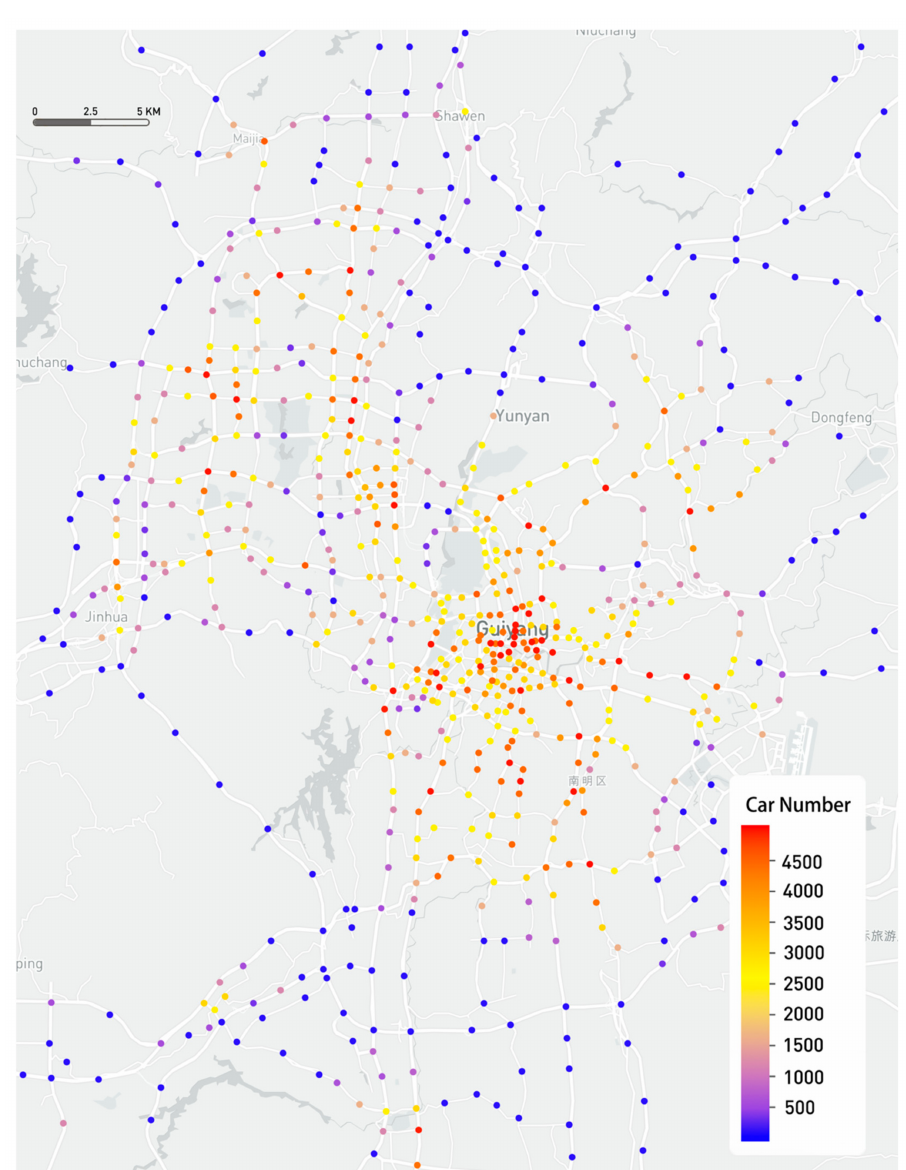
Figure 6. Visualization map of urban road vehicle